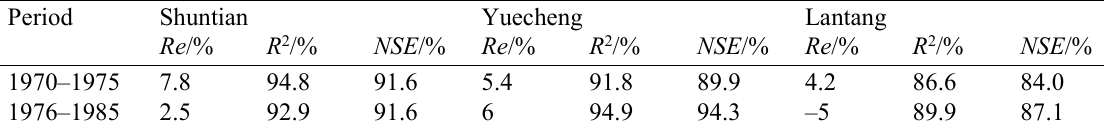
Table 1 The results of calibration and validation in three basins.